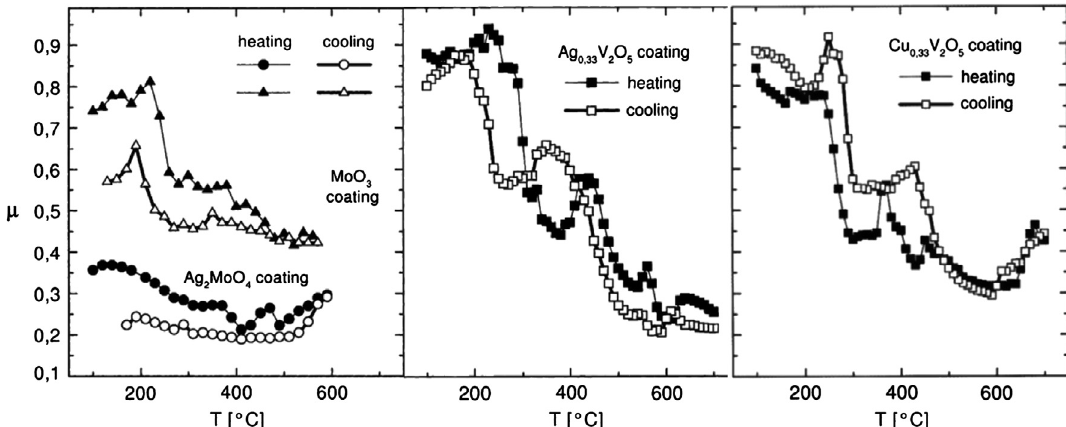
Figure 6. Temperature dependence of CoF for MoO 3 , Ag 2 MoO 4 , Ag 0.33 V 2 O 5 and Cu x V 2 O 5 coatings on alumina substrates. An alumina ball ( U = 8 mm) on disc test with a load of 1 N was used to measure the CoF with a 10 (cid:2) C/min temperature sweep in the range of 100–700 (cid:2) C [30].